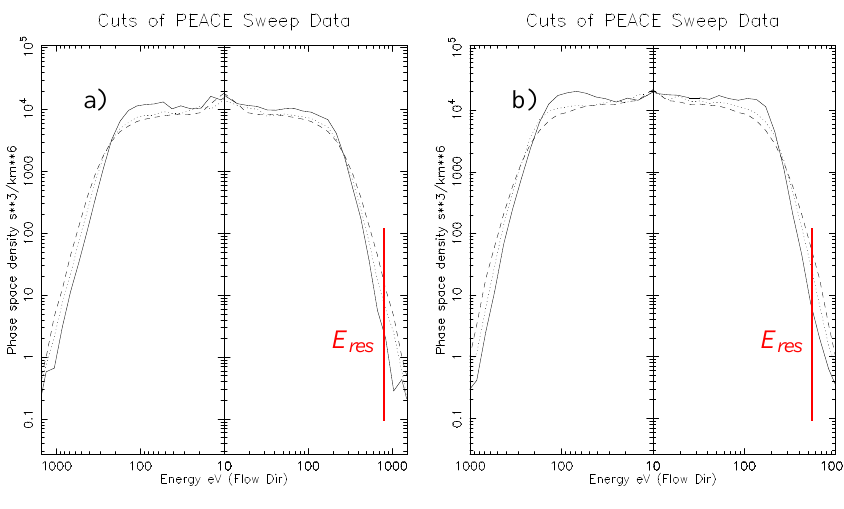
Fig. 6. a) Electron velocity distribution from C1 at 16:51:38 on 10-4-2003 for the case when we find positive Fig. 6. (a) Electron velocity distribution from C1 at 16:51:38 UT on 10 April 2003 for the case when we find positive A e and corresponding lion roars in the data. (b) Electron velocity distribution from C1 at 16:55:19 UT on 10 April 2003 for the case when we see lion roars but no A e and corresponding lion roars in the data. b) Electron velocity distribution from C1 at 16:55:19 on 10-4-2003 positive A e . Format as in Fig. for the case when we see lion roars but no positive A e . Format as in Figure 4.